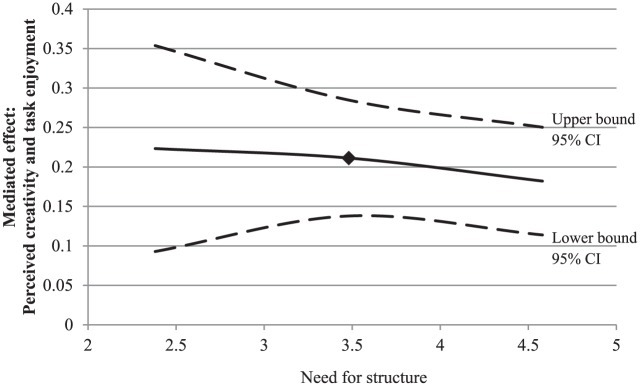
Study 1: A plot of the conditional indirect effect of input novelty
on task enjoyment through perceived creativity, conditioned on the
moderator (need for structure), with 95% confidence bands.Note. The square indicates the mean level of the
need strength. CI = confidence interval.